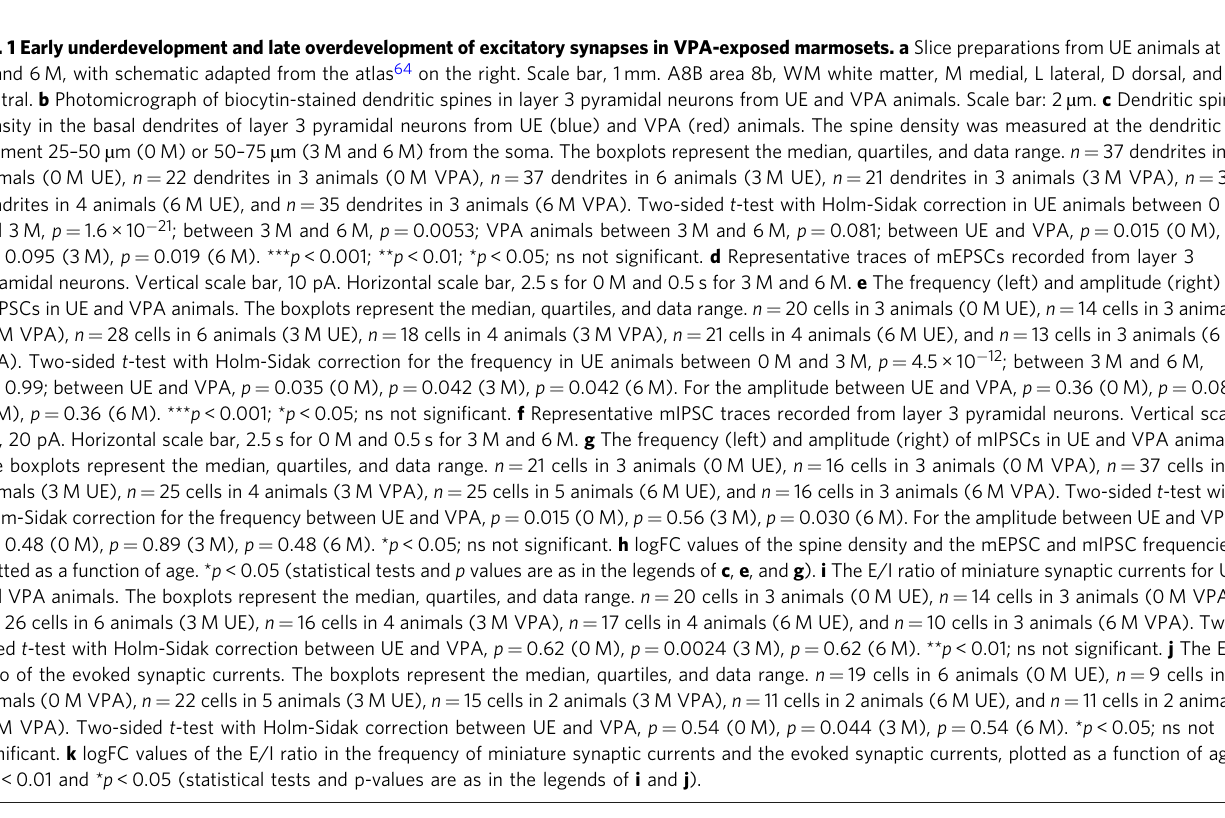
Fig. 1 Early underdevelopment and late overdevelopment of excitatory synapses in VPA-exposed marmosets. a Slice preparations from UE animals at 0, 3, and 6 M, with schematic adapted from the atlas 64 on the right. Scale bar, 1 mm. A8B area 8b, WM white matter, M medial, L lateral, D dorsal, and V ventral. b Photomicrograph of biocytin-stained dendritic spines in layer 3 pyramidal neurons from UE and VPA animals. Scale bar: 2 µ m. c Dendritic spine density in the basal dendrites of layer 3 pyramidal neurons from UE (blue) and VPA (red) animals. The spine density was measured at the